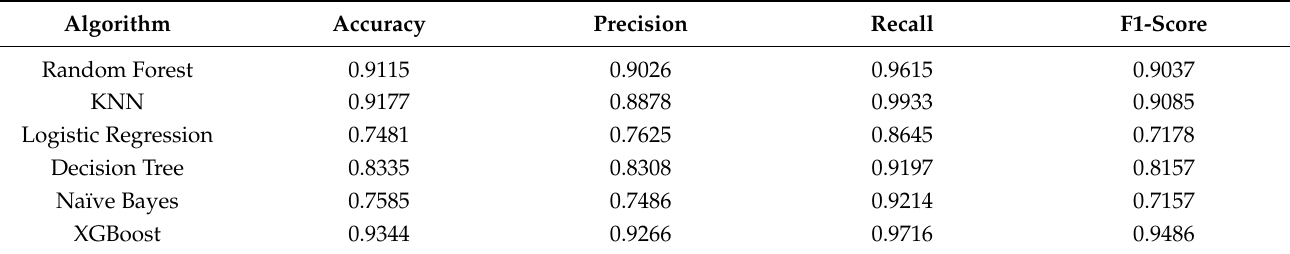
Table 4. The results of six